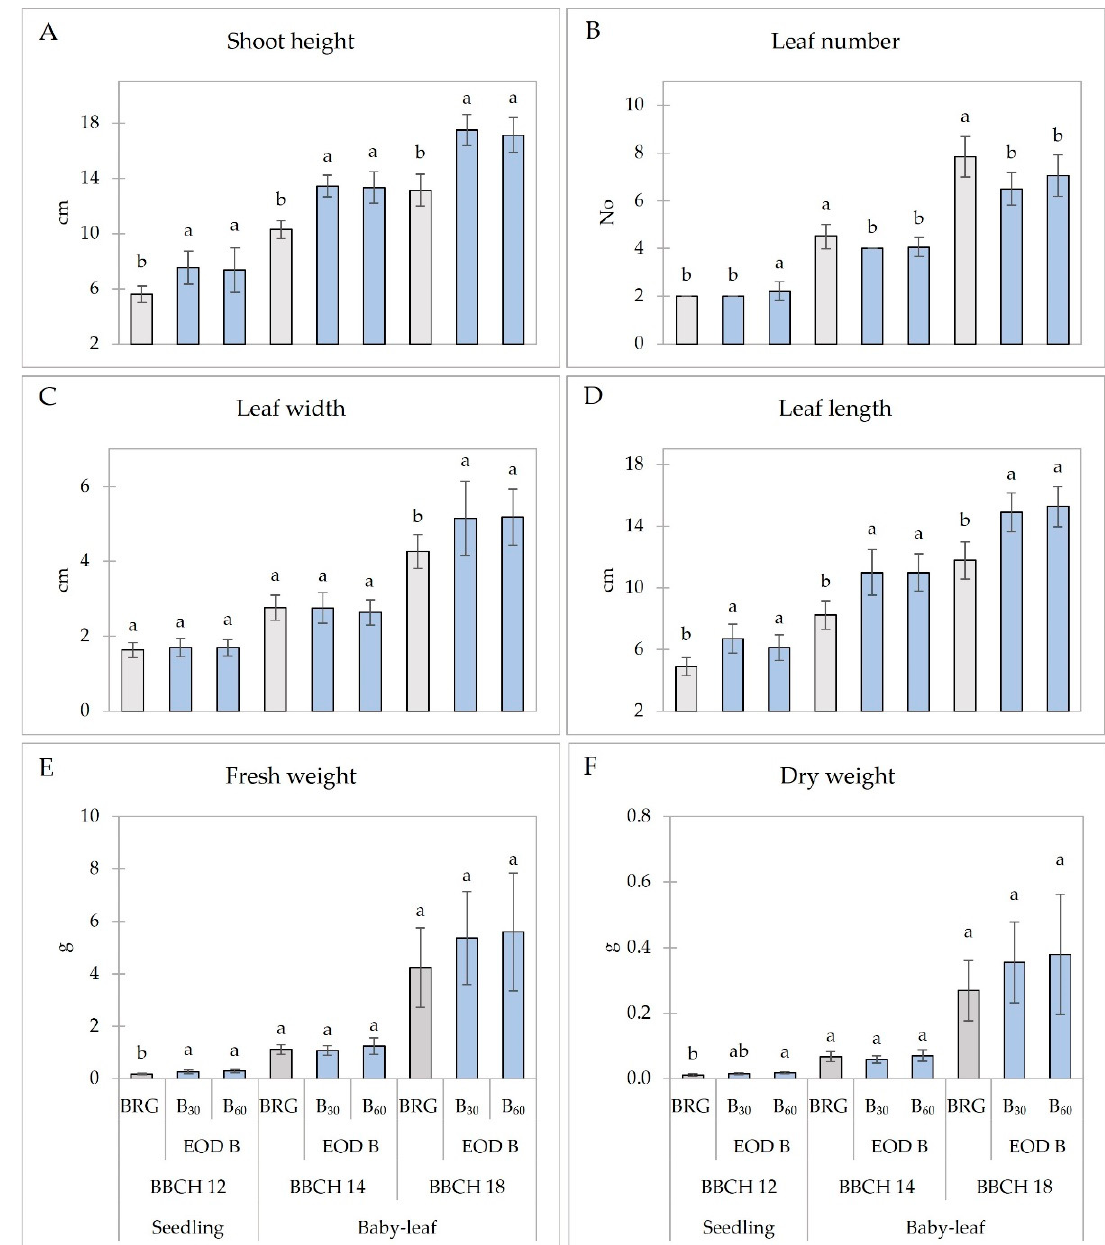
Figure 1. Biometric indices (( A ) shoot height; ( B ) leaf number; ( C ) leaf width; ( D ) leaf length; ( E ) fresh weight; ( F ) dry weight) of lettuce plants at different development stages. BRG , 5% blue (peak = 450 nm), 85% red (peak = 660 nm), 10% green (peak = 530 nm) for 16 h d –1 (Control; from 06:00 to 22:00); B 30 and B 60 , PPFD of end-of-day lighting with blue (peak = 450 nm) at 30 and 60 µmol m –2 s – 1 , respectively; EOD, end-of-day lighting for 4 h d –1 (from 22:00 to 02:00). Data are means of two replications with ten samples per replication (n = 20). Means with different letters are significantly different from the control treatment (BRG) at p < 0.05.